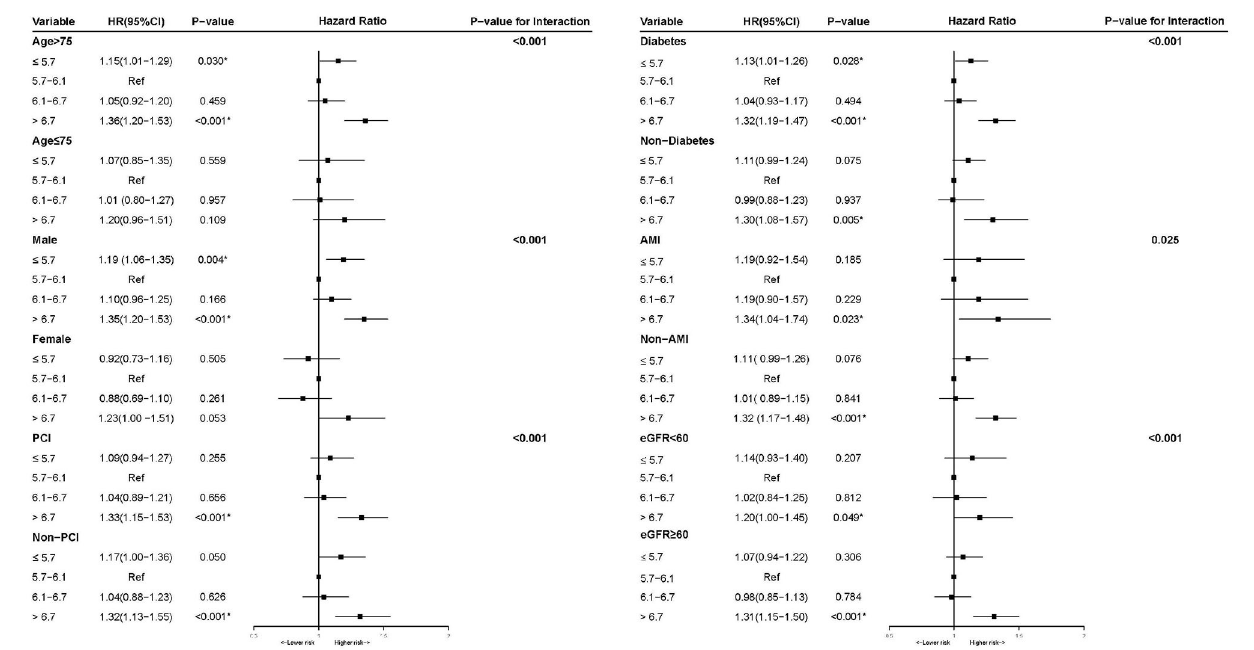
FIGURE 4 | Multivariable cox proportional hazard ratios for long-term all-cause mortality in Subgroups stratified by patients’ characteristics and